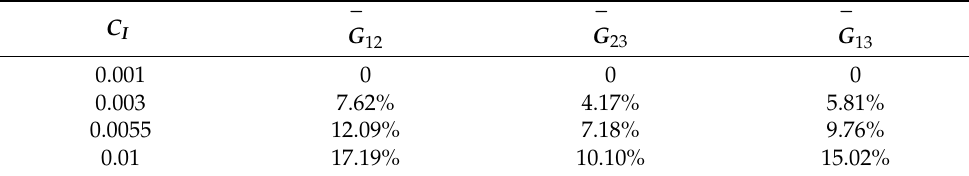
Table 6. PRDs of computed mean shear elastic constants of 13 wt.%. CF/ABS deposited bead. C I